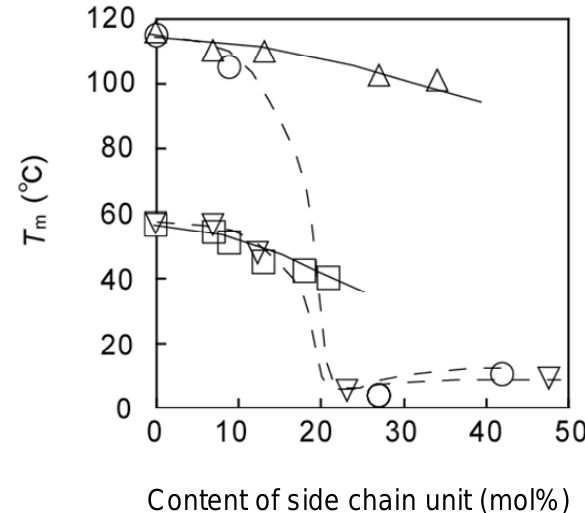
Figure 6. T of PBS/M-6 ( △ ), PHS/M-6 ( □ ), PBS/M-16 ( ○ ) and PHS/M-16 ( ▽ ) with m various monomer